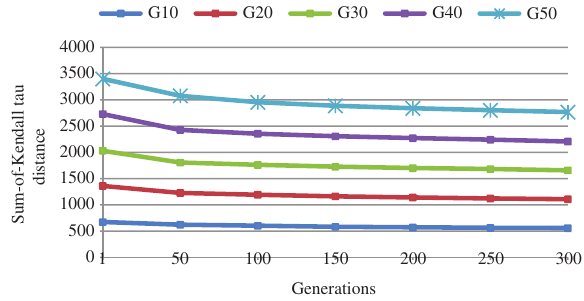
Figure 12: For Different Group Sizes Variation of Sum-KtD across Generations.